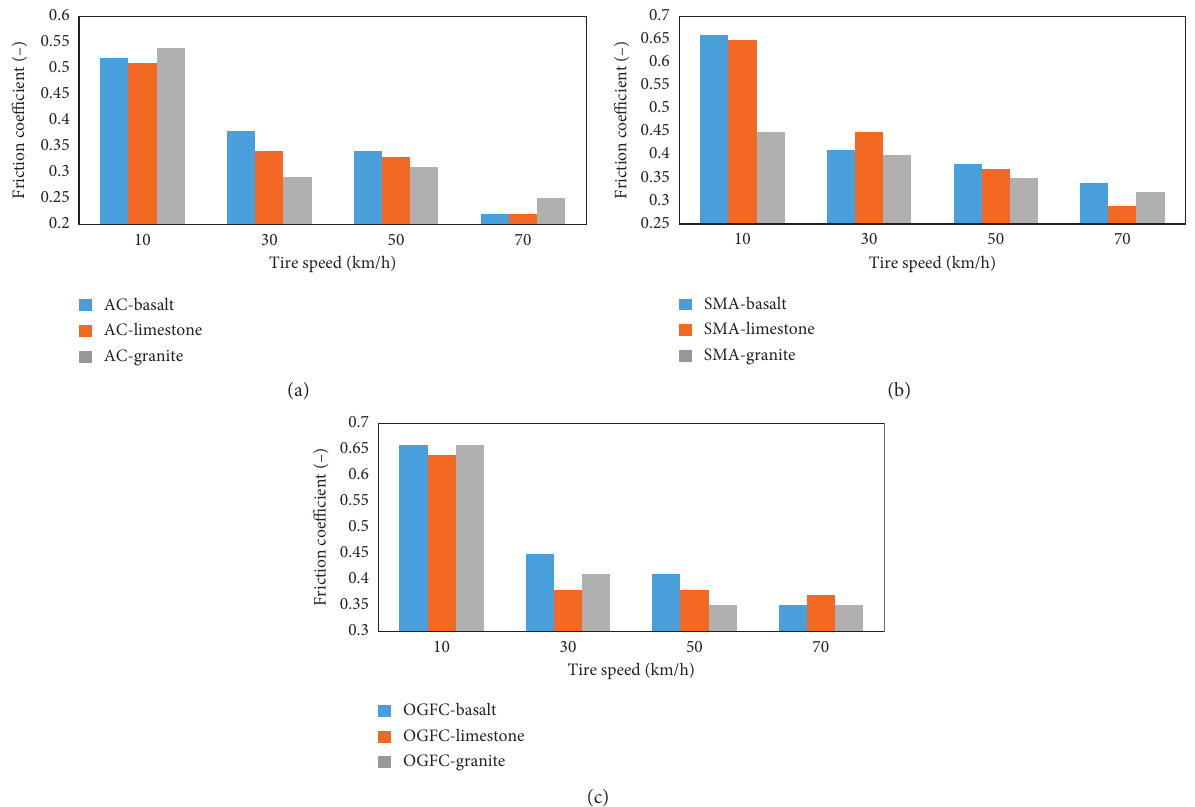
Figure 5: The effect of tire speed on the pavement friction coefficient. (a) The AC pavement friction coefficient under different tire speeds. (b) The SMA pavement friction coefficient under different tire speeds. (c) The OGFC pavement friction coefficient under different tire